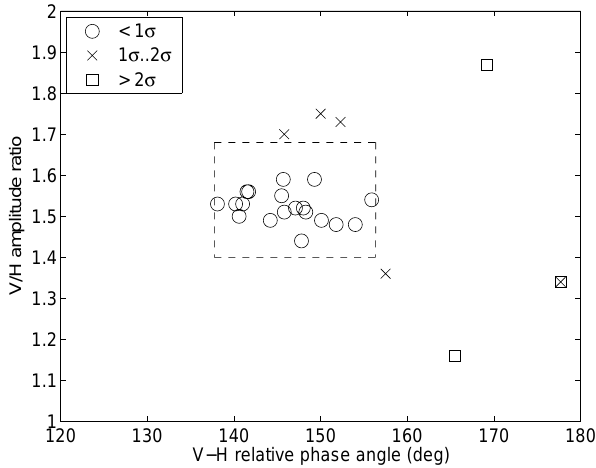
Fig. 7. Scatter plot showing the distribution of the 7 October 2009 events in ρ − φ space. Most events show essentially the same V/H amplitude ratio and E V − E H phase difference irrespective of direc- tion of arrival and aspect angle; 19 events out of a total of 26 are clustered within less than 0.11 units from ρ mean and less than 10 ◦ from φ mean